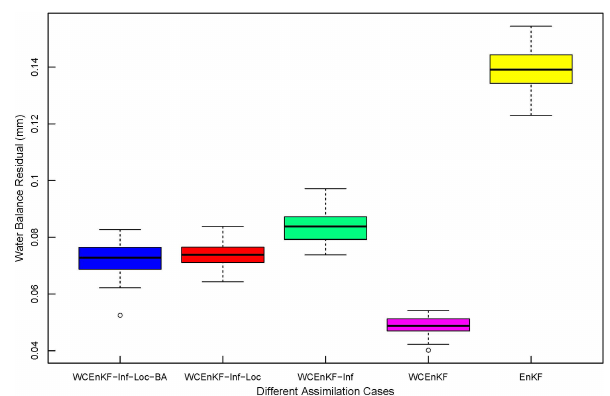
Figure 6. The box plot of the water balance residual in all 40 pixels for the WCEnKF-Inf-Loc-BA, WCEnKF-Inf-Loc,WCEnKF- Inf, WCEnKF and EnKF assimilation